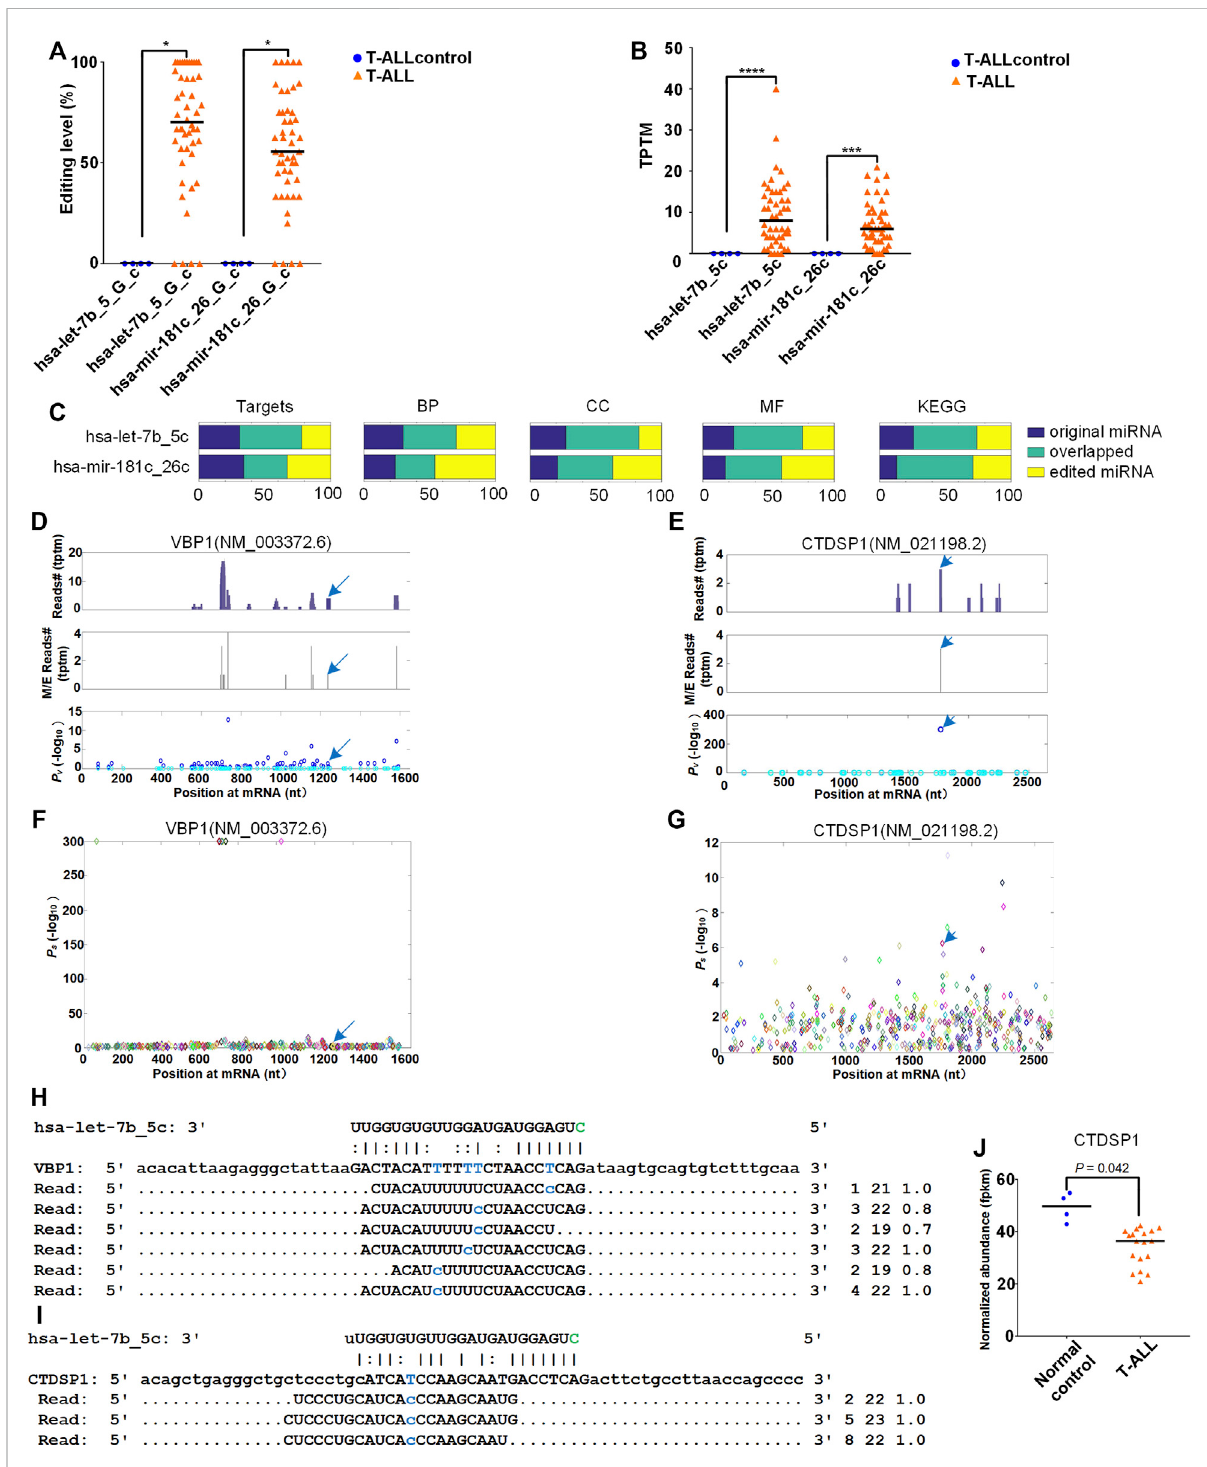
FIGURE 5 Target analysis of original and edited miRNAs in T-ALL. The detailed legend is provided on the next page. Target analysis of original and edited miRNAsinT-ALL. (A) Thecomparisonsoftheeditinglevelsoftwo5 ′ -editingsitesinT-ALLandT-ALLcontrolsamples. “ * ” indicatescorrected p -value < 0.05, Mann-Whitney U -tests (B) Comparisons of normalized expression levels (TPTM) of hsa-let-7b_5c and hsa-mir-181c_26c in the T-ALL and T-ALLcontrolsamples. “ **** ” and “ *** ” indicatecorrected p -values < 0.0001and0.001,respectively,edgeR (C) Thecomparisonsoftargets,GO terms, and KEGG pathways of original and two 5 ′ -edited miRNAs. The GO terms Biological Process (BP), Cellular Component (CC) and Molecular